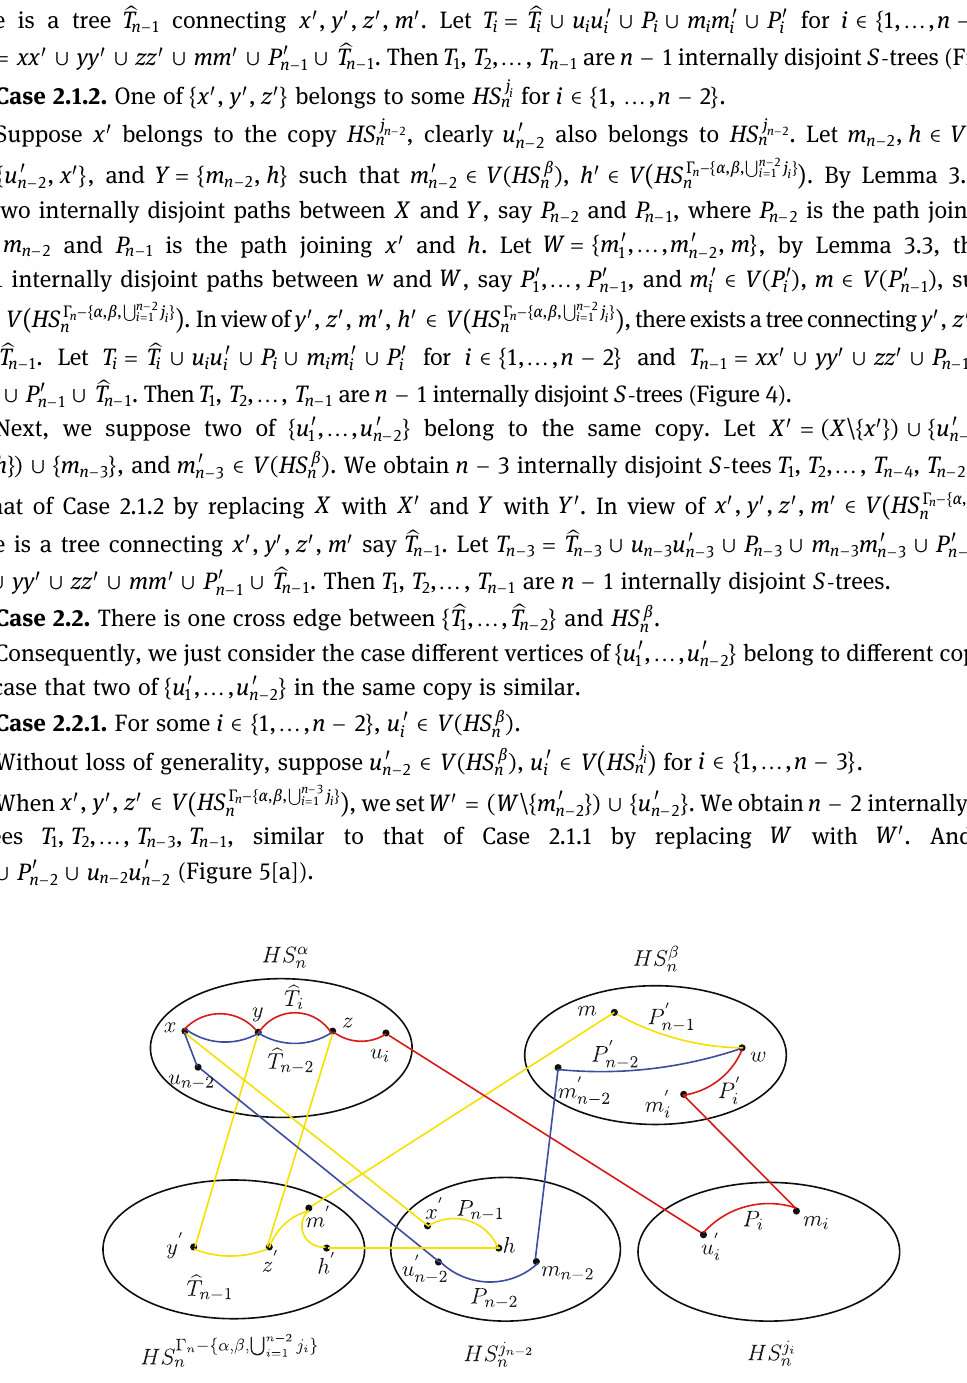
Figure 4: The illustration of Case